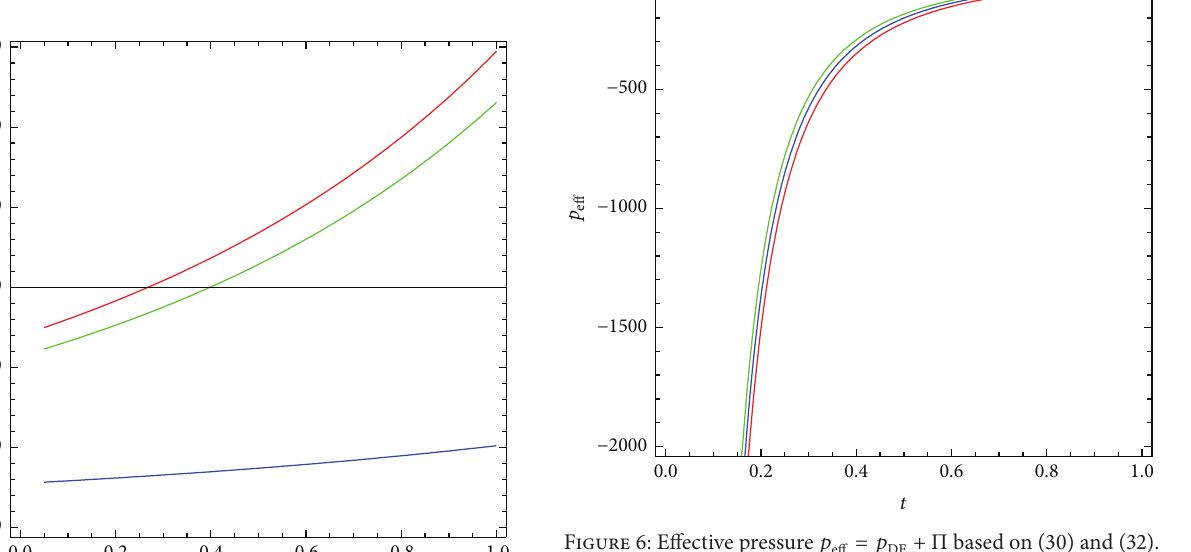
Figure 6: Effective pressure 𝑝 eff = 𝑝 DE + Π based on (30) and